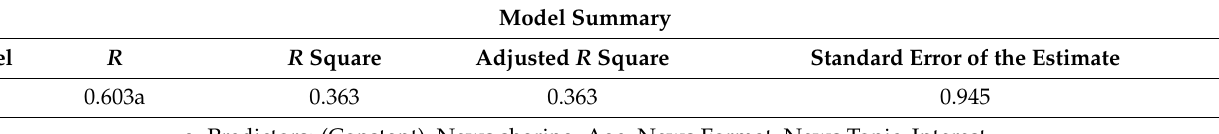
Table 6. Multiple Linear Regression. Credibility as dependent